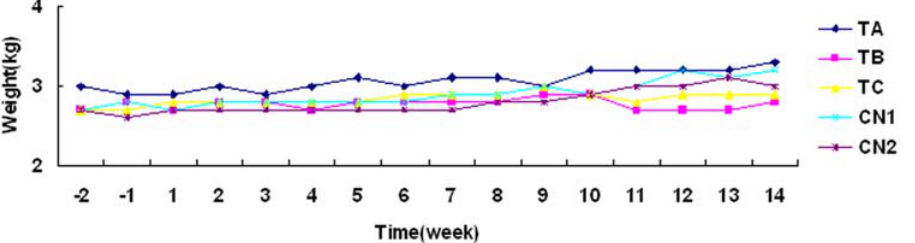
Figure 4. The weight change in a long-term experiment in monkeys immunized with the influenza vaccine. ‘ 2 1’ refers to 1 week before the vaccine immunization. Vaccine immunizations occurred during weeks 1 to 10. Weeks ‘11 to 14’ refered to the time post-immunization.